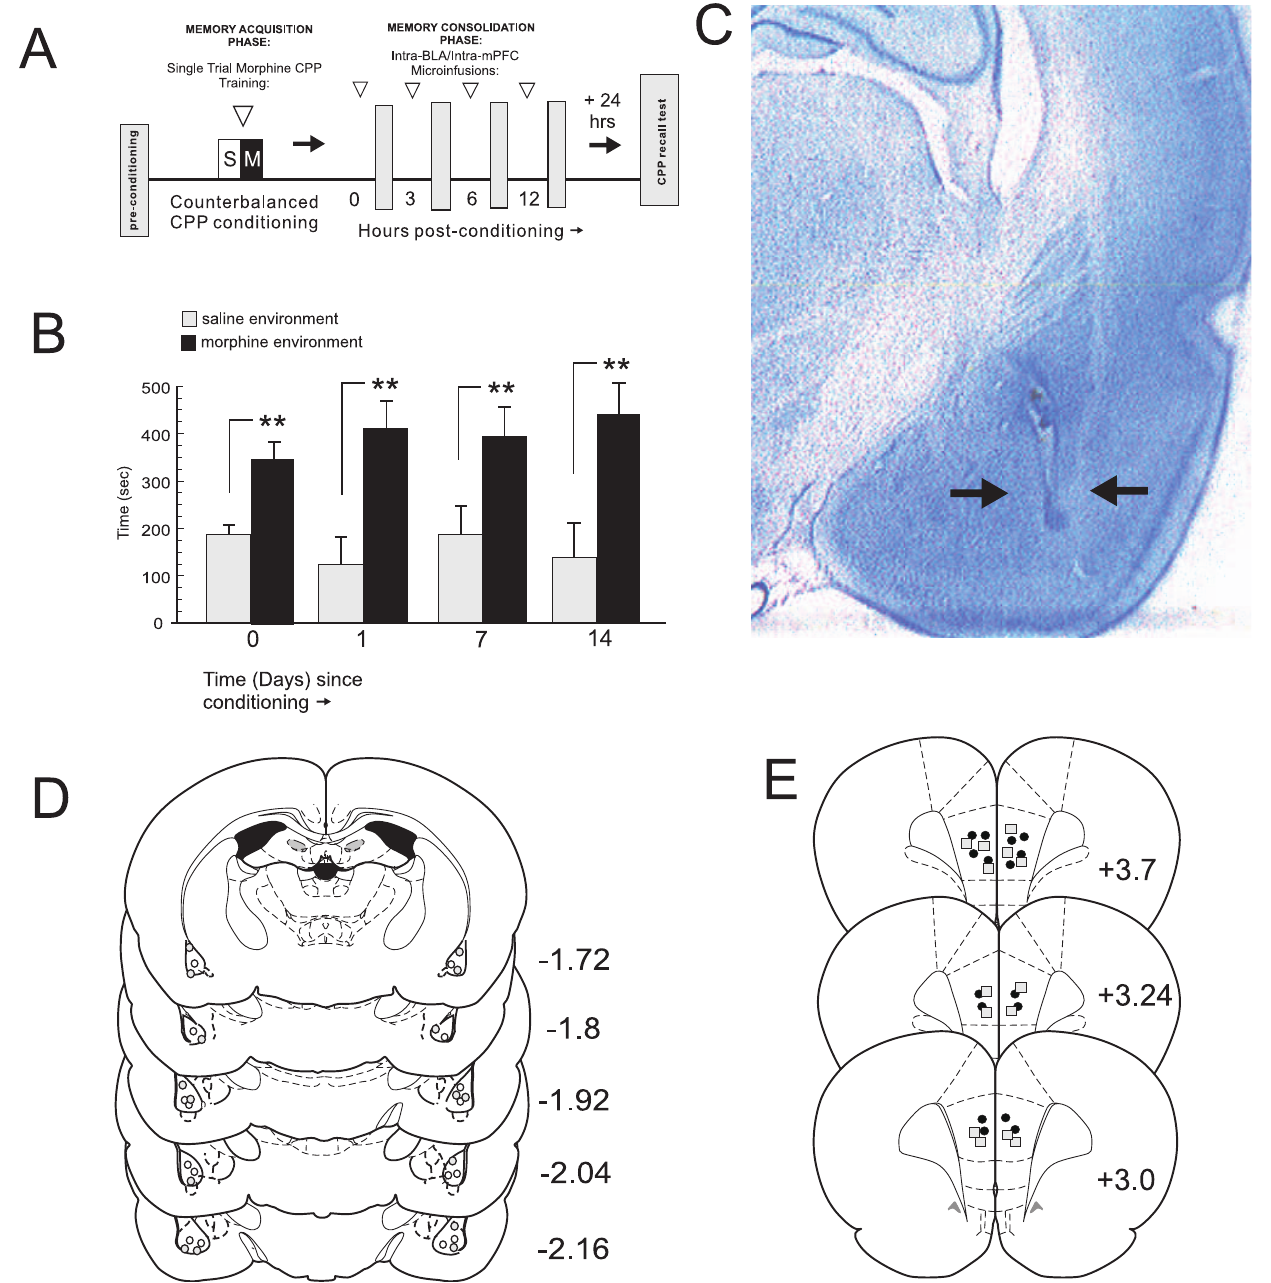
Figure 1. Experimental protocol, opiate reward memory CPP expression and intra-BLA histological analysis. A , Schematic summary of single-trial, acute morphine reward memory CPP conditioning procedure. B , Long-term stability of morphine single-trial CPP reward conditioning demonstrated by significant morphine-environment CPP up to 14 days post-conditioning. C , Microphotograph showing representative intra-BLA injector tip location (black arrows). D , Schematic summary of representative intra-BLA microinfusion sites for rats receiving intra-BLA ANI at 0 hrs (grey circles) or 12 hrs (white circles) post-conditioning. *=p , .05; **=p , .01 for this and all subsequent figures. E, Schematic summary of representative intra-mPFC microinfusion sites for rats receiving intra-BLA ANI at 0 hrs (grey squares) or 12 hrs (black circles) post-conditioning. *=p , .05; **=p , .01 for this and all subsequent figures. doi:10.1371/journal.pone.0063612.g001 lin-dependent kinase II (CaMKII) [18–21]. Testing our previously determined early vs. late-phase CPP memory consolidation time points (0 and 12 hrs), we pharmacologically targeted either ERK1/2 or CaMKII signalling within the BLA and mPFC by performing bilateral microinfusions of the CaMKII inhibitor KN-